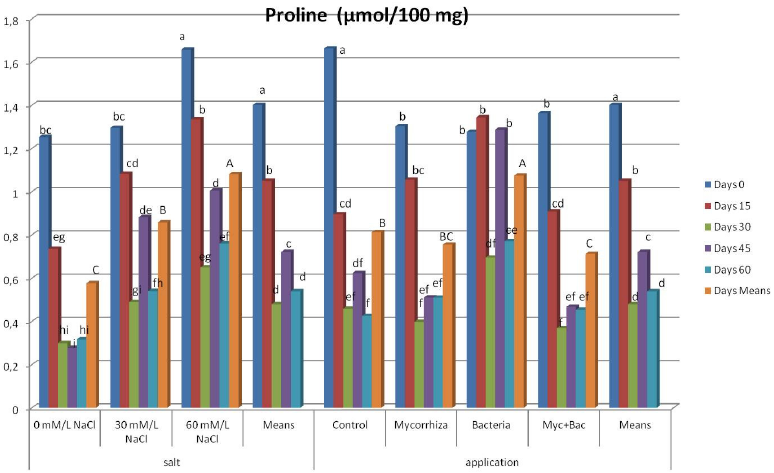
nin content increased in line with the increasing salt